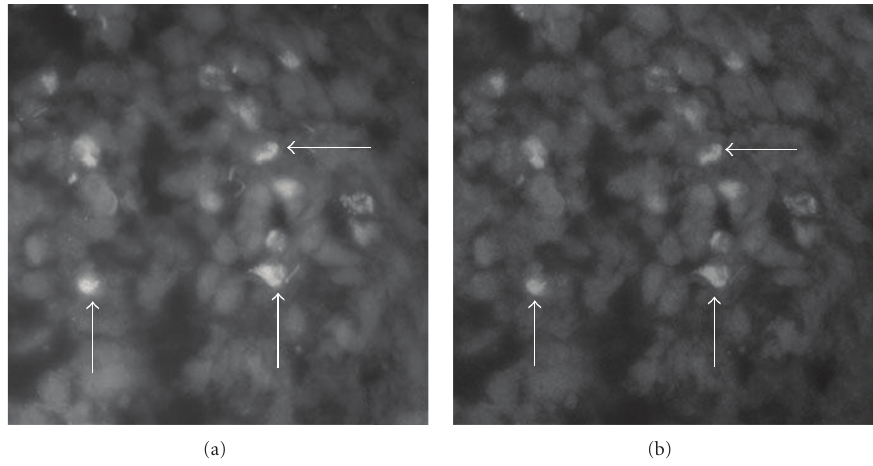
Figure 6: (a, b) Inflammatory infiltrate in a soleus muscle (myositis specimen). Double-staining for demonstration of TNF-alpha (a) and CD68 (b). Immunoreactions are seen in the same cells